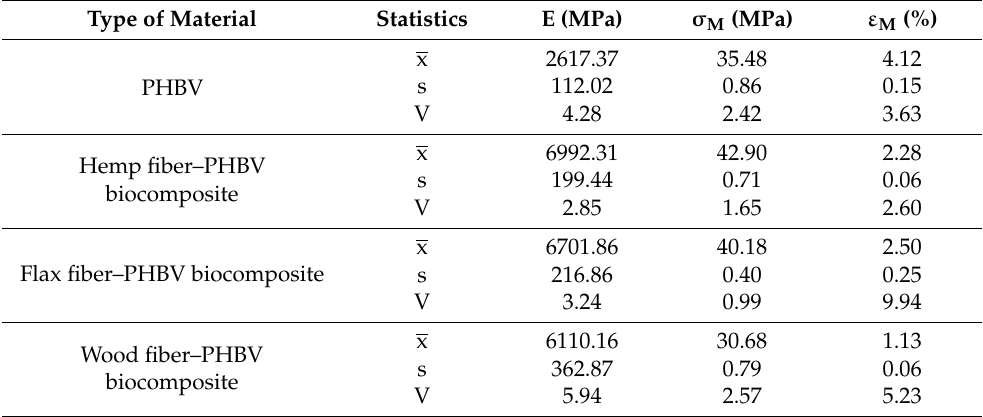
Table 4. The results from uniaxial tensile test for pure polymers and biocomposites with different filler types. Type of Material